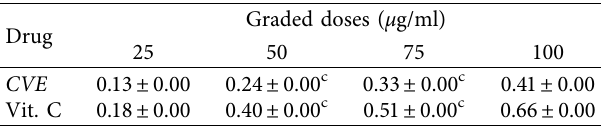
Table 6: In vitro FRAP activities of 25–100 μ g/ml of CVE and vitamin C.